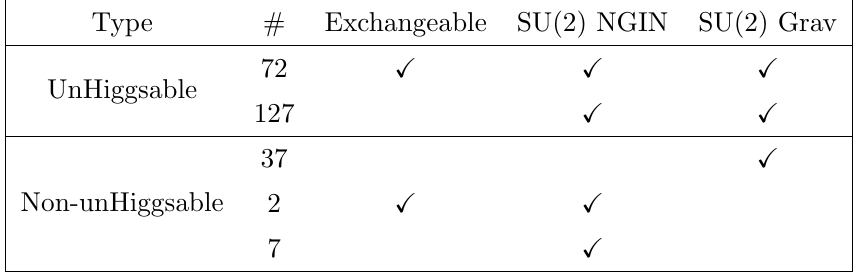
Table 2 . Classes of j q j (cid:20) 3 models satisfying the U(1) AC conditions, as well as the integrality and non-negativity conditions. Classes are grouped into two types: those unHiggsable to an anomaly- free SU(2) model and those that are